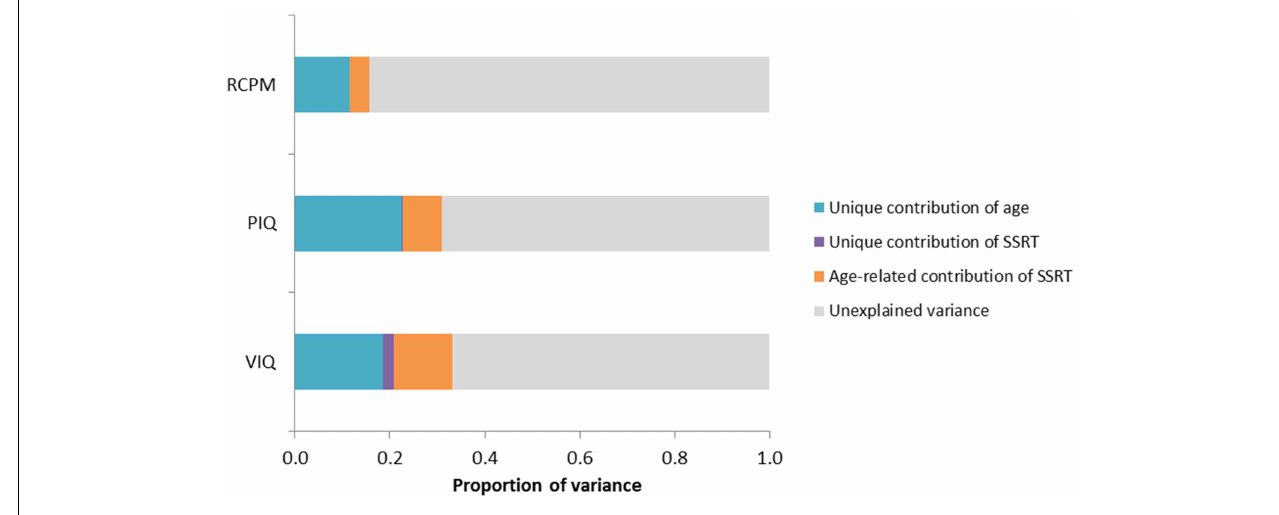
FIGURE 3 | Bar chart showing variance partitioning for VIQ, PIQ, and RCPM. The variance explained by age was significant in all IQ scores, but SSRT significantly predicted unique variance only in VIQ but